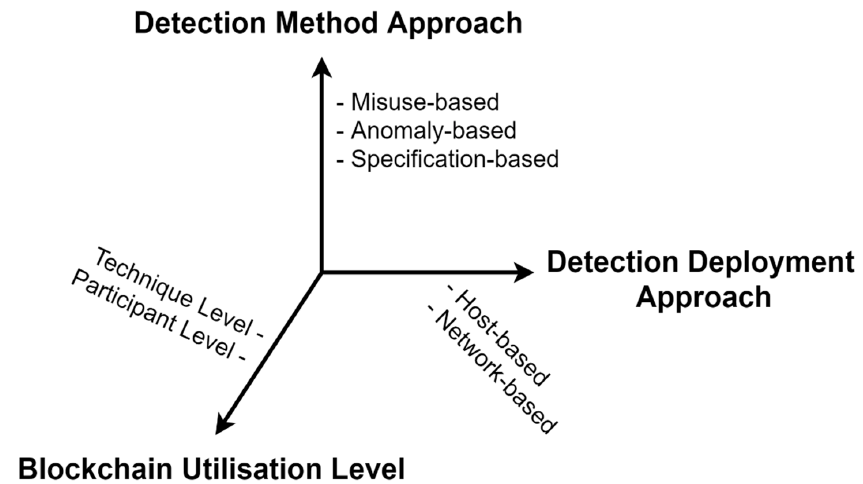
Figure 1. Classification criteria.